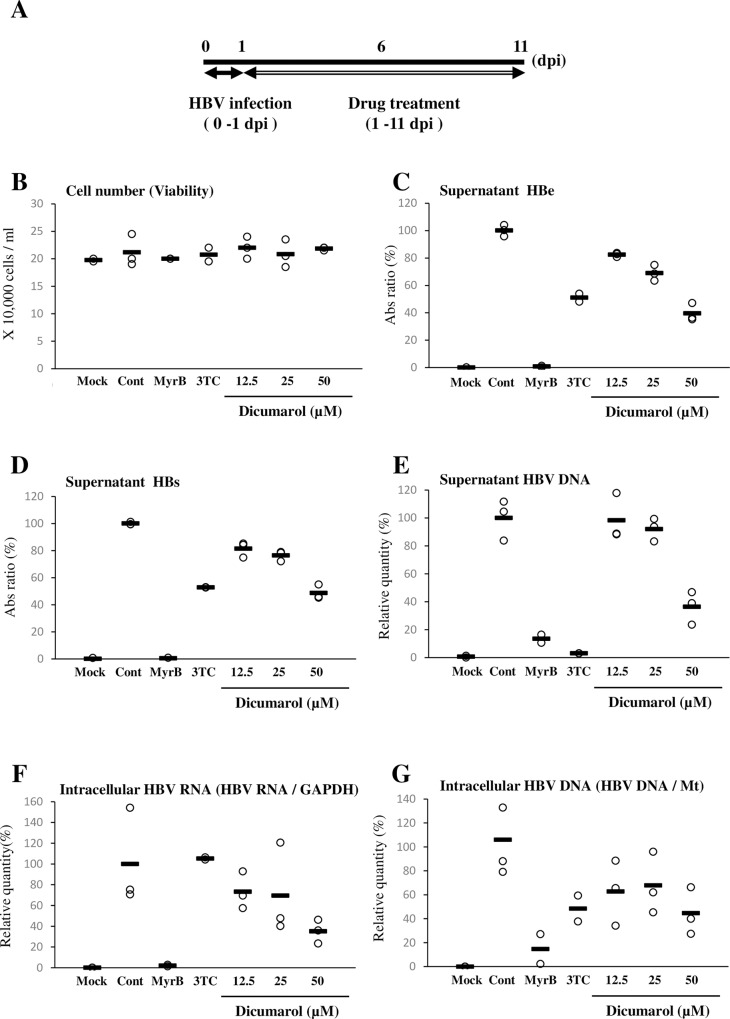
Dicumarol inhibits HBV replication in HBV-infected primary human hepatocytes.(A) Experimental scheme. PXB cells were infected with HBV in the absence or presence of MyrB at 0–1 dpi. At 1 dpi, the virus-containing medium was removed and a dicumarol-containing medium was added. Every 2 days, the medium was changed and samples were collected at 11 dpi. 3TC: 500 nM lamivudine, which is a reverse transcriptase inhibitor. (B) Cell viability was examined by counting the trypan blue-negative cell number. (C) HBe in the culture supernatant. (D) HBs in the culture supernaIt. (E) The DNA in the supernatant was extracted and quantified by qPCR. (F) Intracellular HBV RNA was quantified by qPCR. (G) Intracellular HBV DNA was quantified by qPCR. Data are means ± SD of at least duplicate measurements.